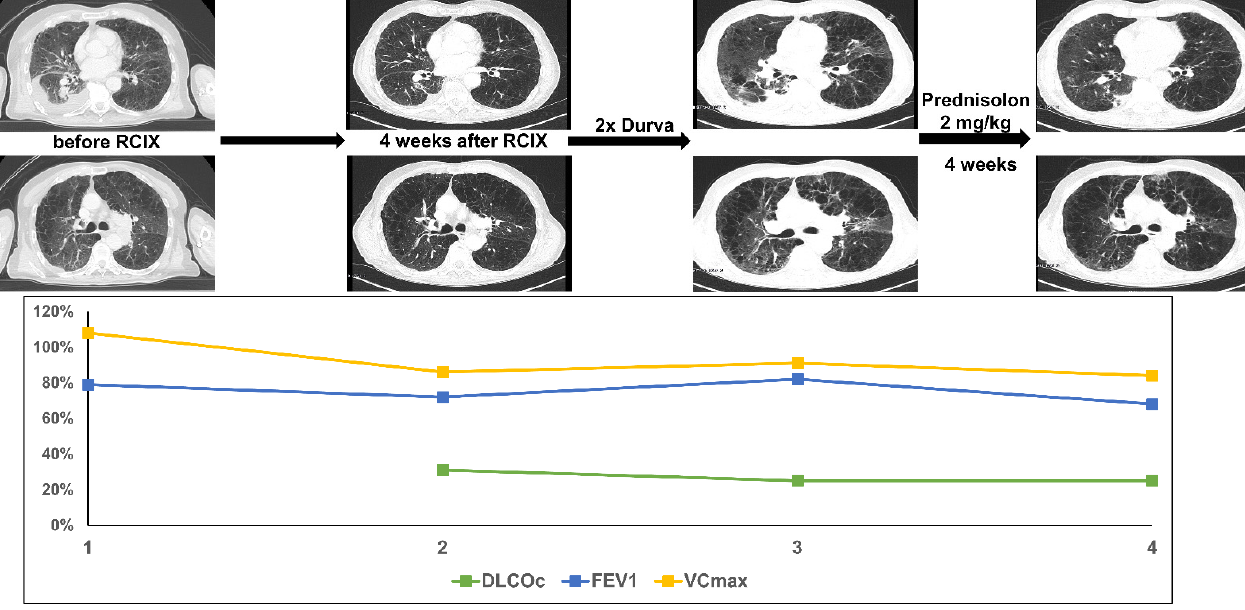
Figure 4. The figure shows course of treatment, corresponding CT imaging and lung function values of patient 4. (RCIX: Radiochemoimmunotherapy; Durva: Durvalumab).